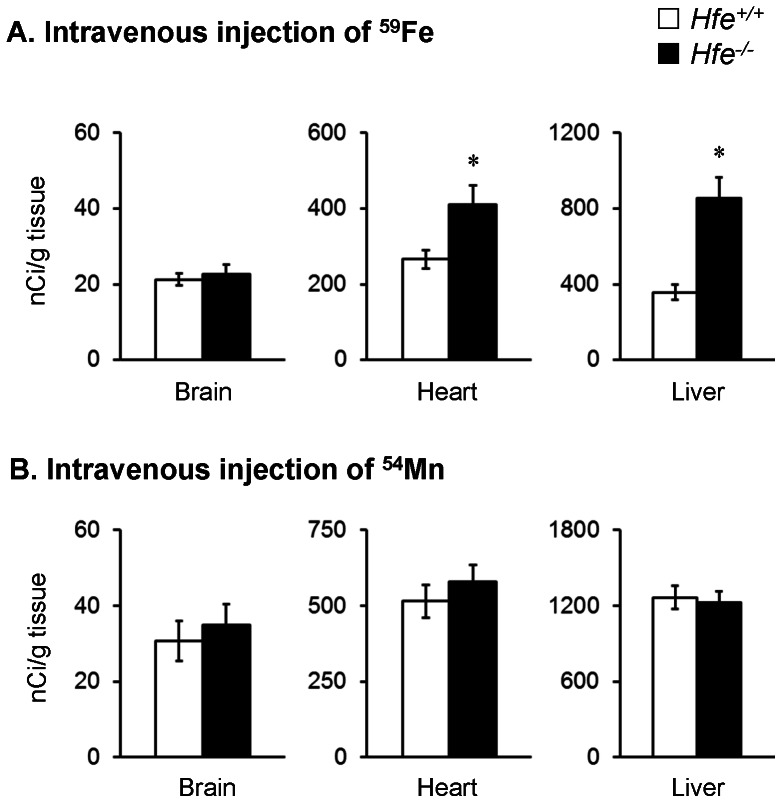
Uptake of injected 59Fe and 54Mn to brain, heart and liver.Levels of 59Fe in brain, heart and liver (as nCi/g tissue) were characterized 4 h post-dose of 59FeCl3 (200 mCi/kg body weight) to mice by intravenous injection (A). Levels of 54Mn in brain, heart and liver (as nCi/g tissue) were characterized 1 h post-dose of 54MnCl2 (200 mCi/kg body weight) to mice by intravenous injection (B). Empty and closed bars represent Hfe
+/+ and Hfe
−/− mice, respectively. Data were presented as mean ± SEM (n = 4−5 per group for 59Fe and n = 7−8 per group for 54Mn). * P<0.05 between Hfe
+/+ and Hfe
−/− mice determined by two-sample t-test.